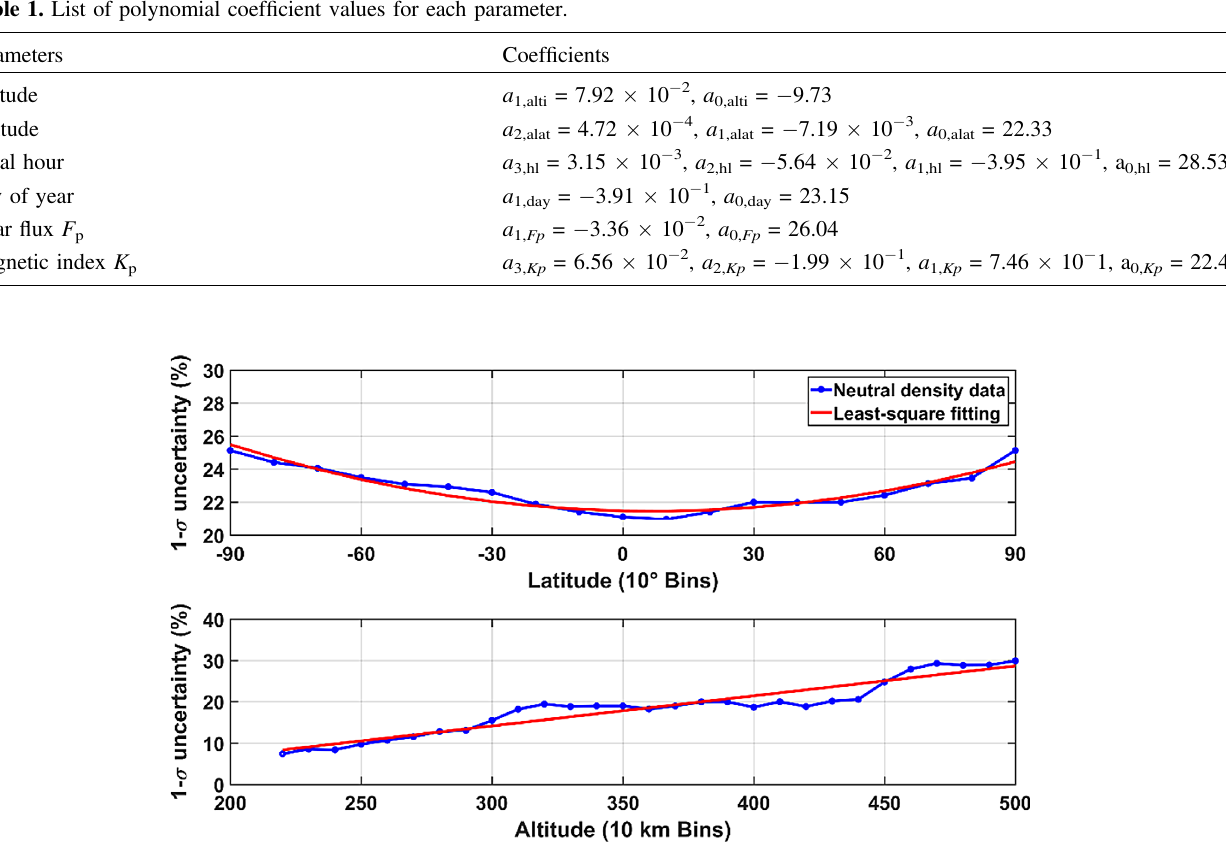
Fig. 4. (Top) 1- r uncertainty in percent binned in latitude and the model fi tting to data in the least-squares (LS) sense, (bottom) 1- r uncertainty in percent binned in altitude, and the model fi tting to data in the least-squares sense. Data is in blue, and the LS fi tting in red